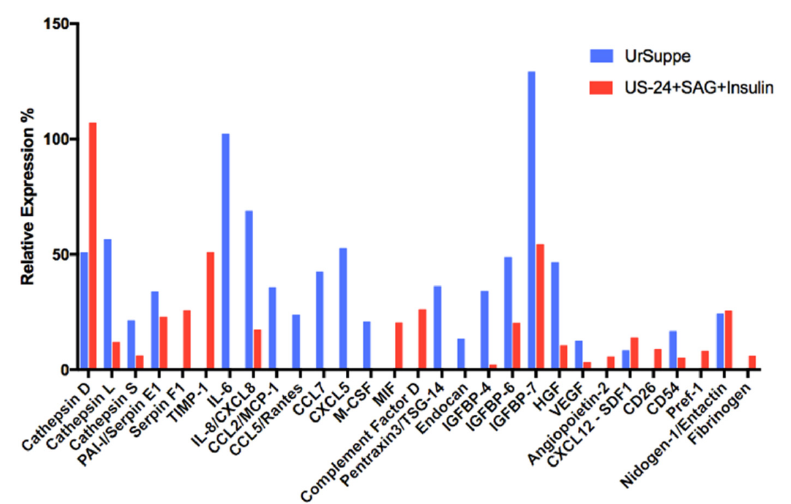
Figure 8. Proteome profiler of hASCs growth in UrSuppe (blue bar) or US-24 with SAG and Insulin medium (red bar). Data are represented as Mean Pixel Intensity (MPI) of fluorescence measured by the Licor acquisition system. Measured values were normalized on background fluorescence and on positive control to obtain a Relative MPI. This experiment was performed with